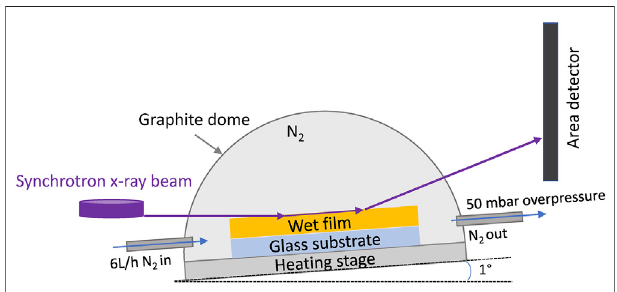
FIGURE 1 | 2D contour plots of the azimuthally integrated GIWAXS detector frames obtained as a function of time during crystallization of MAPbI 3 from DMSO, DMF, NMP, GBL at 40, 50, 58, 78, and 100 ° C. Wavelength 1.5406 Å is equivalent to Cu K α 1 .